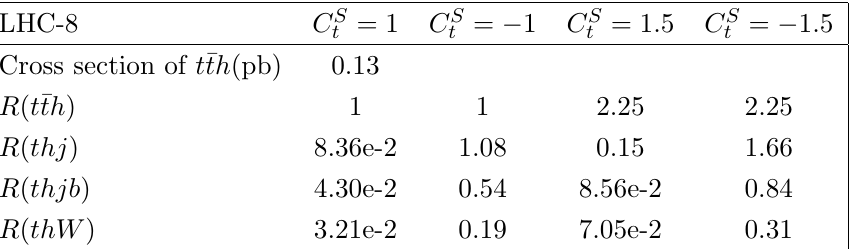
= (cid:6) 1 ; (cid:6) 1 : 5. t